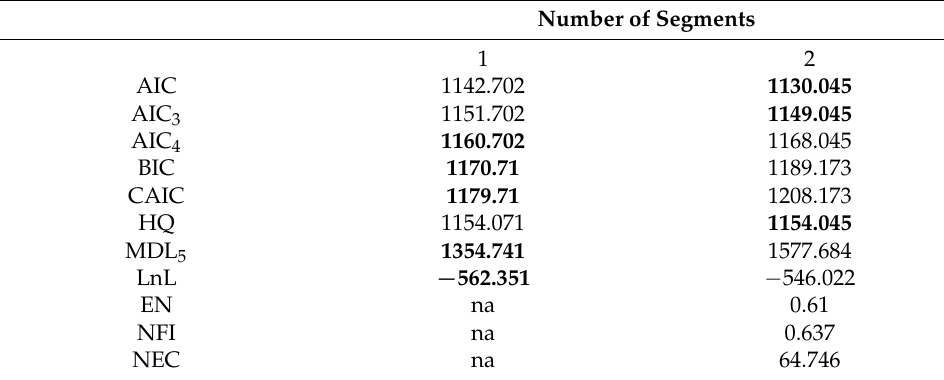
Table 7. Fit indices for the one to two segments